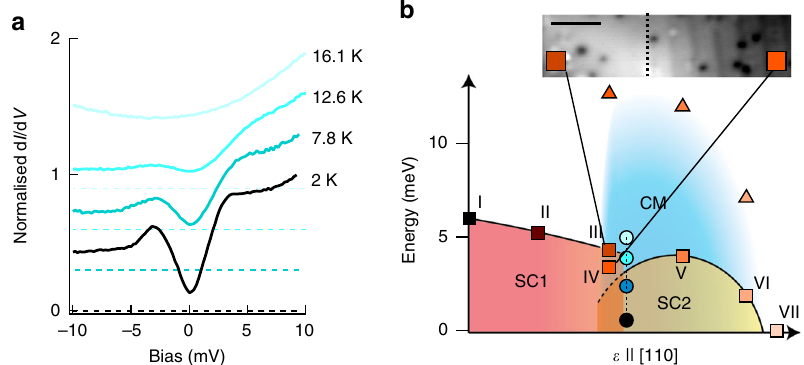
Fig. 4 Phase diagram of LiFeAs as a function of uniaxial strain. a d I /d V spectra acquired on LiFeAs in the modulated phase at different temperatures (all spectra normalised at V = 10 mV, Dashed horizontal lines are zero conductance for each spectrum, V s = 10 mV, I s = 0.15 nA). b Phase diagram of LiFeAs as a function of uniaxial strain along [110], with the superconducting gap size (squares) and the characteristic energy of the CDW (triangles) as a function of strain. STM images showing coexistence between SC1 and CM/SC2 (see inset) indicate a fi rst order phase transition to the modulated phase. Roman numerals and colours of squares and triangles refer to spectra in Fig. 1f. Round points corresponding to spectra in a are positioned at 3.57 k B T , using Δ / k B T c determined from the temperature dependence in a . Inset: topographic image of an area showing coexistence of SC1 and SC2/CM phases. Scale bar: 6 nm. A large-scale topographic image showing the coexistence of the two phases is shown in Supplementary Fig. 6